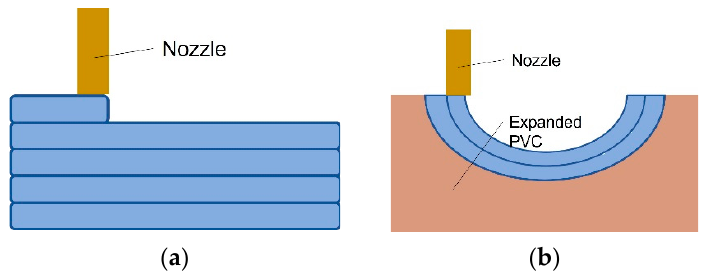
Figure 4. Schematic representation of material deposition of ( a ) traditional FFF layered manufactur ‐ ing; ( b ) 3D curved layer supported by CNC milled mould. ( b ) 3D curved layer supported by CNC milled